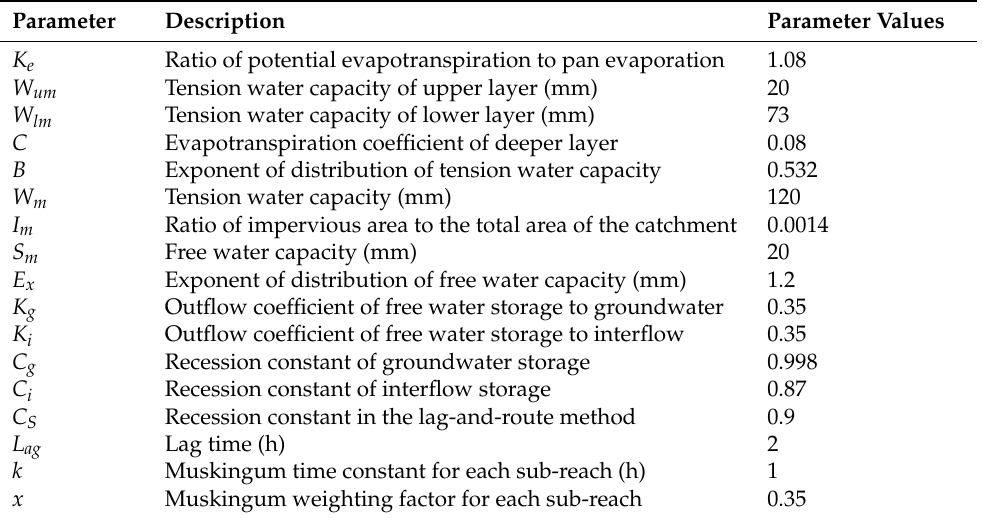
Table 2. List of calibrated parameters of the Xin’anjiang model.